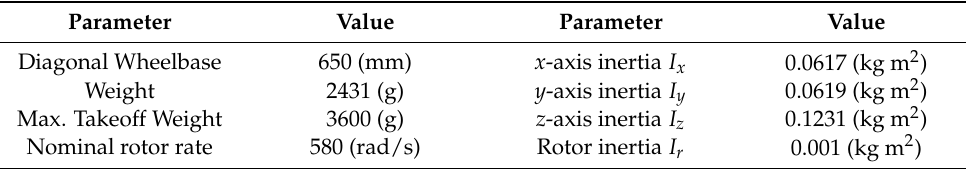
Table 1. List of DJI Matrice 100 geometrical parameters.